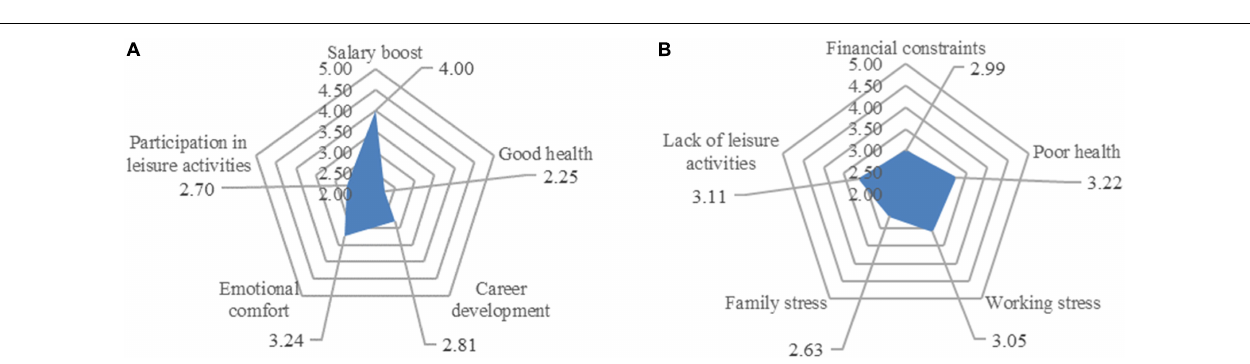
FIGURE 4 | Life satisfaction of professional females based on various attributes.